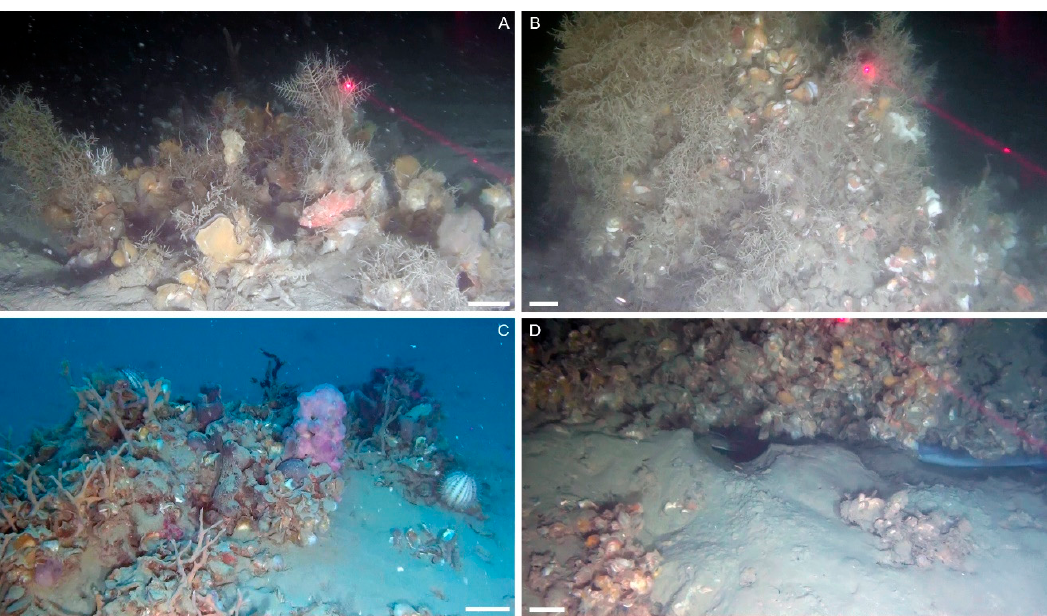
Figure 3. Different typologies of Neopycnodonte cochlear reefs in the southern Adriatic and northern Ionian Apulian shelf. ( A ) Dense Neopycnodonte growth on a flat sea-bottom at ca. 90 m (Monopoli), offering substrate for the colonial polychaete belonging to Filograna-Salmacina complex, undetermined bryozoans and hydrozoans turf; bar = 10 cm. ( B ) Close-up of ( A ) imaging the density of N. cochlear at this site; bar = 3 cm. ( C ) Juvenile specimens of N. cochlear colonizing a derelict fishing gear at 100 m (Santa Maria di Leuca) document quick oyster colonization of hard substrates here; bar